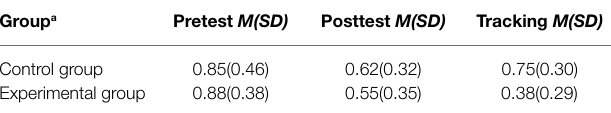
TABLE 5 | Mean IAT effect values (D) by